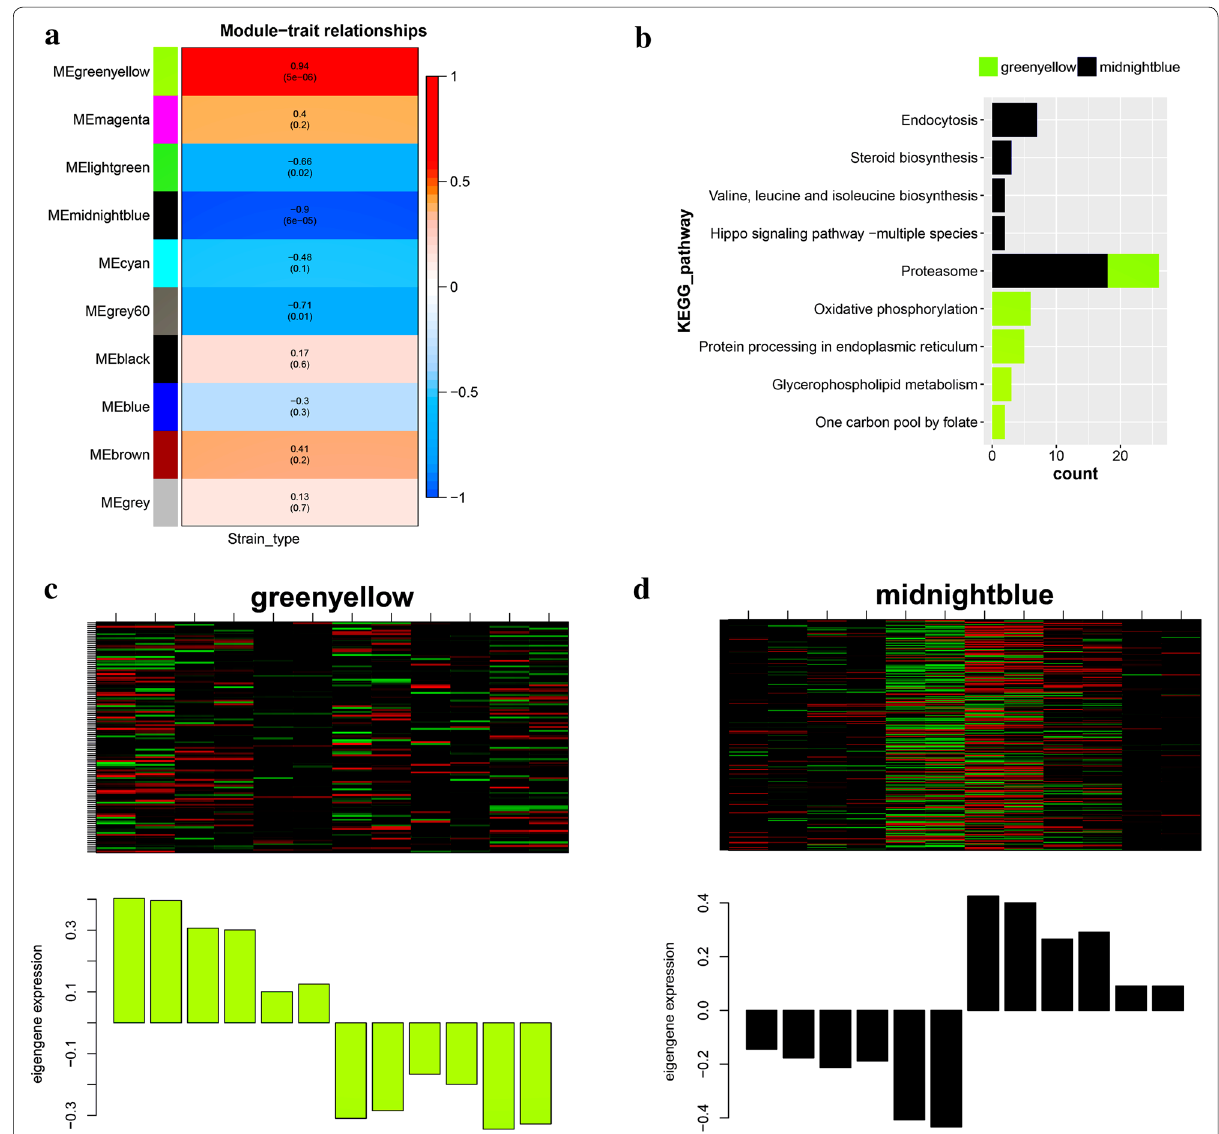
Fig. 3 Correlation analysis of traits in the WGCNA module and their heatmap. a P value and module–trait relationships of each WGCNA modules. b KEGG pathway enrichment of the green-yellow module and midnight-blue module. c , d Eigen gene expression patterns of the green-yellow module and midnight-blue module: (i) Gene expression heat map; (ii) Eigen gene expression histogram of the modules. Each column of the heat map represents a sample and corresponds to a sample of the gene expression histogram. Each row of the heat map represents a